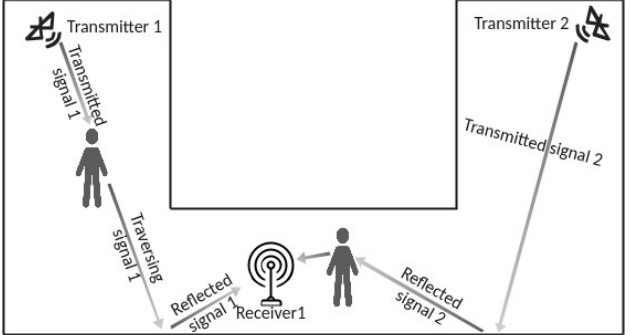
Figure 3. Constraints on the number and position of beacons and receivers. The beacons must be placed in such a way as to illuminate each occupant in the monitored room. The receivers must be placed in such a way that for each occupant, at least one transmission from a beacon traverses the occupant and is received by one of the receivers. The transmission may be reflected by some surface, i.e., it is not necessary that the occupant lays on the Line of Sight between the beacon and the receiver. As the BLE devices are not synchronized, we cannot exploit the phase shift of different messages sent at the same time, for example, to improve spatial resolution [36]. Conse- quently, we prefer to sacrifice temporal resolution for noise robustness and combine the RSSI of k messages, sent by the same i -th beacon and received by receiver r with similar timestamps around the time instant t , into a single representative sample calculated as the median of the k RSSI values, which we call the Median RSSI Sample received by r at time t ( MRS r , i ( t ) ). This approach strongly reduces the effects of unwanted abrupt changes in RSSI due to the AFH mechanism of the BLE protocol, while also reducing the temporal resolution (that is, the PHS sampling frequency) by a factor of k . The temporal subsampling introduced above is illustrated in Figure